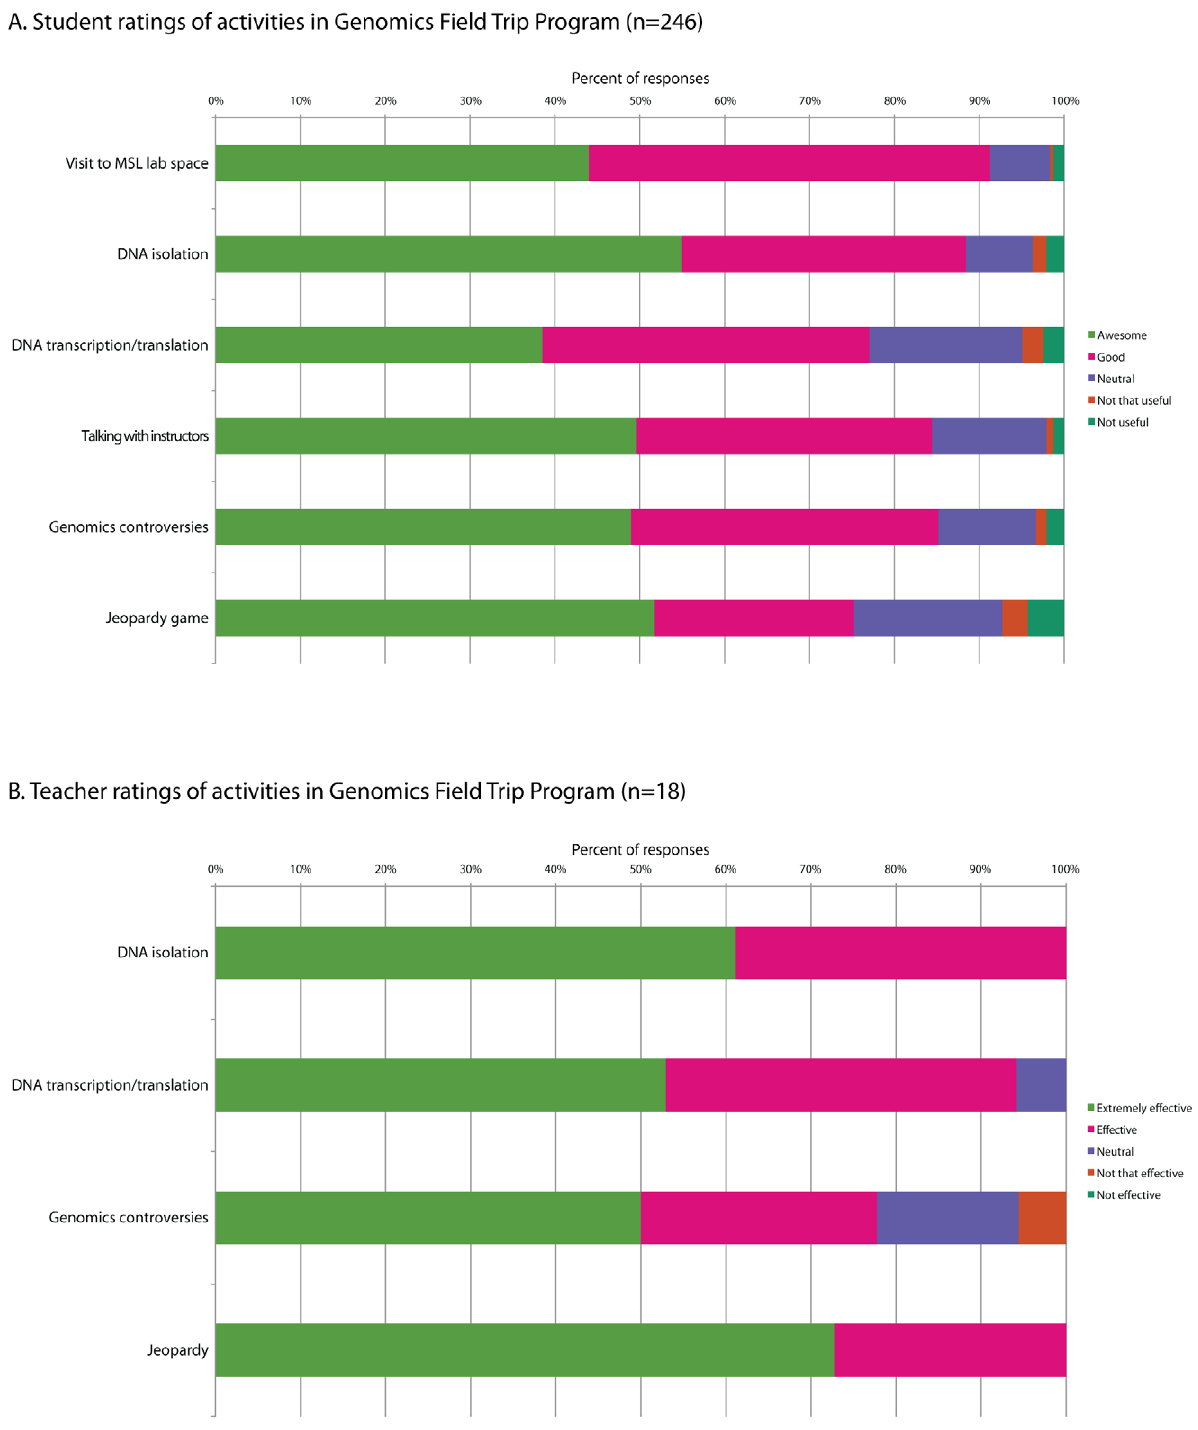
Figure 1. Ratings of field trip activities by students and teachers. (A) Student and (B) teacher ratings of activities in Genomics Field Trip Program sessions occurring between September 2011 and February 2012 ( n =246 and 18, respectively, from 14 different classroom